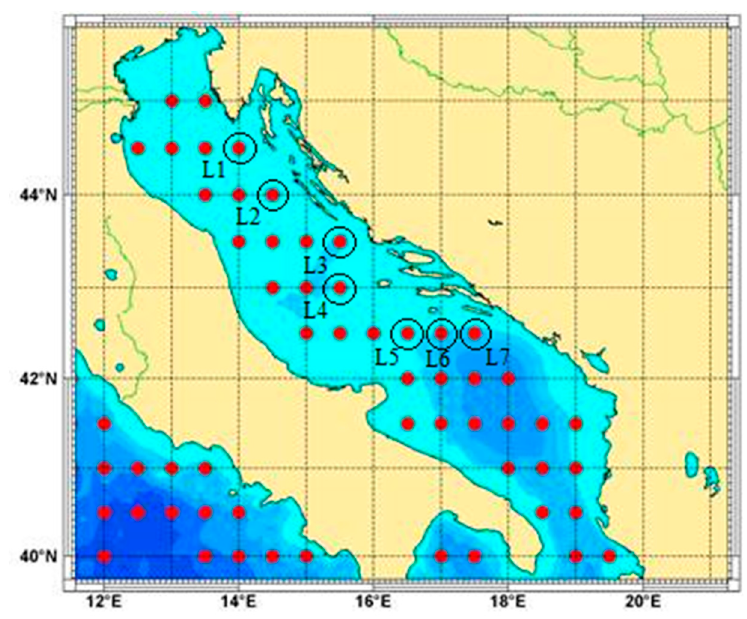
Figure 1. O ff shore grid points provided in WWA for the Adriatic Sea. Source: Oceanor. Figure 1. Offshore grid points provided in WWA for the Adriatic Sea. Source: Oceanor.